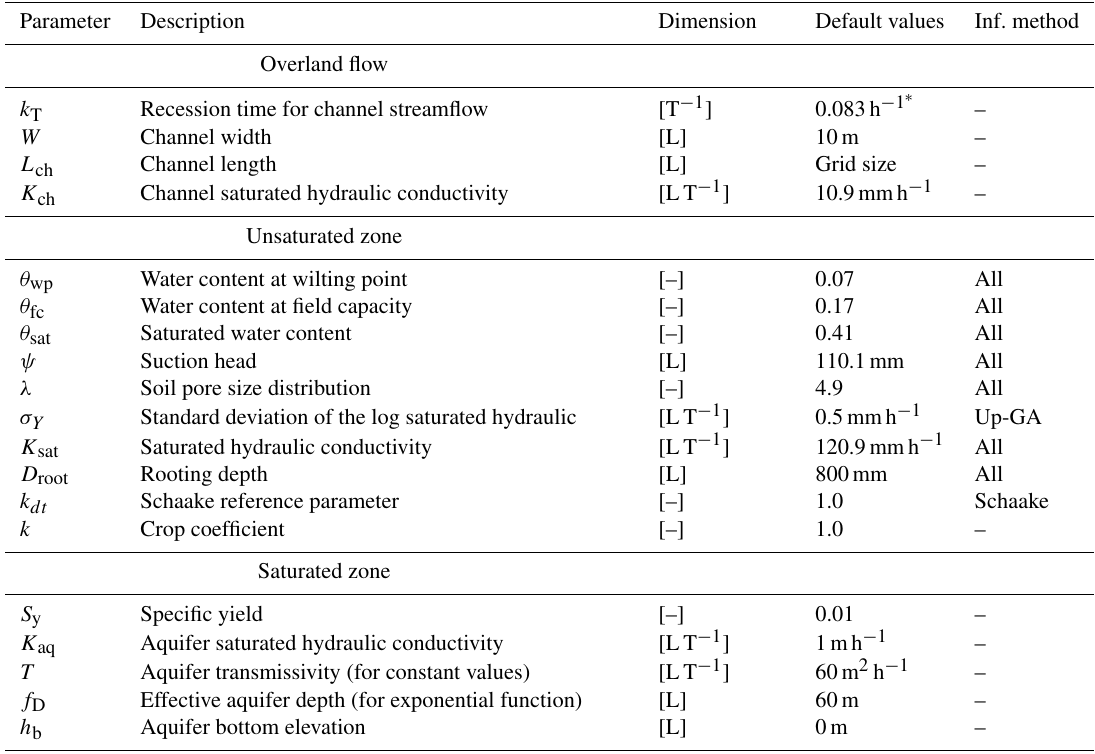
Table 1. Model parameters for different processes considered in the model; some required parameters depend on the infiltration approach (“Inf. method”). For soil hydraulic properties, default values correspond to a sandy loam soil texture (Clapp and Hornberger, 1978; Rawls et al.,